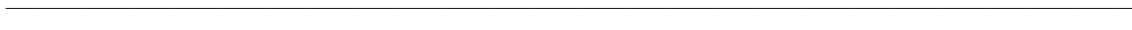
Fig. 2. Guerichosteus heterolepis (Preobrazhensky, 1911), branchial, orbital, postorbital plates and tubercle from the body scale (A–P), vertical thin section (Q, R) from the Tori locality and vertical thin sections (S–V) from the Taali locality, Pärnu RS, Middle Devonian of Estonia. A – C , TUG 1552-2, lectotype, fragment of the left branchial plate; A, dorsal, B, ventral, C, transverse views. D, E , GIT 116-1, fragment of the left branchial plate; D, dorsal, E, ventral views. F , GIT 116-2, orbital plate, lateral and ventral sides. G , GIT 116-3, postorbital plate, dorsal view. H , I , details of ornamentation from GIT 116-1. J , detail of ornamentation from the lateral side of GIT 116-2. K–M , details of ornamentation from GIT 116-3. N–P , PM SPU 87-2, tubercle from body scale GIT 116-8; N, lateral view; O, top view; P, detail of its microsculpture. Q–R , PM SPU 87-2, thin section of the tubercle; Q, R, in polarized light using crossed Nicols. S , PM SPU 87-3, thin section of tubercle from median plate PM SPU 87-1 in ordinary transmitted light. T – V , PM SPU 87-4, thin section of median plate PM SPU 87-1; T, tubercle; U, V, details of its microstructure. SEM SE images – N–O; SEM BSE images – P, T–V, J–O. Abbreviations: at, aspidin trabeculae; dl, dorsal lamella of the branchial plate; dt, dentine; dtt, dentine tubules; dt/en – junction of tissues; en, enameloid; l.en, lower layer of enameloid; pc, pulp cavity; m-tub, microtubercles of the crown; rr, radial ribs on the crown; u.en, upper layer of enameloid; va, vascular canals of